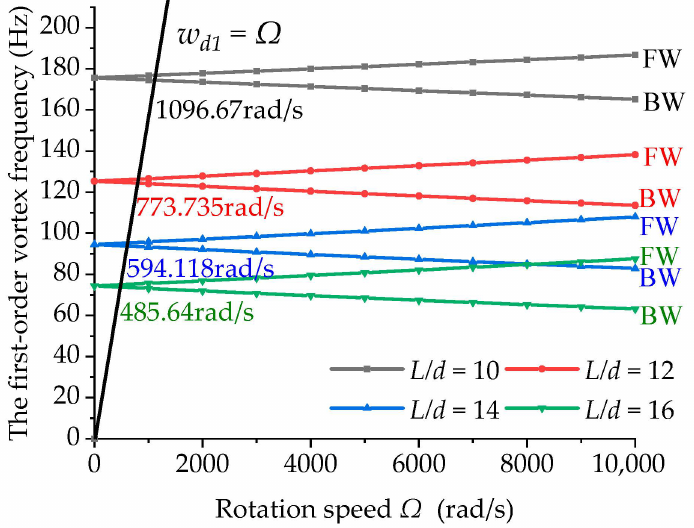
Figure 4. Effect of the length-to-diameter ratio on the first-order vortex frequency ( TR = 1 and ψ =